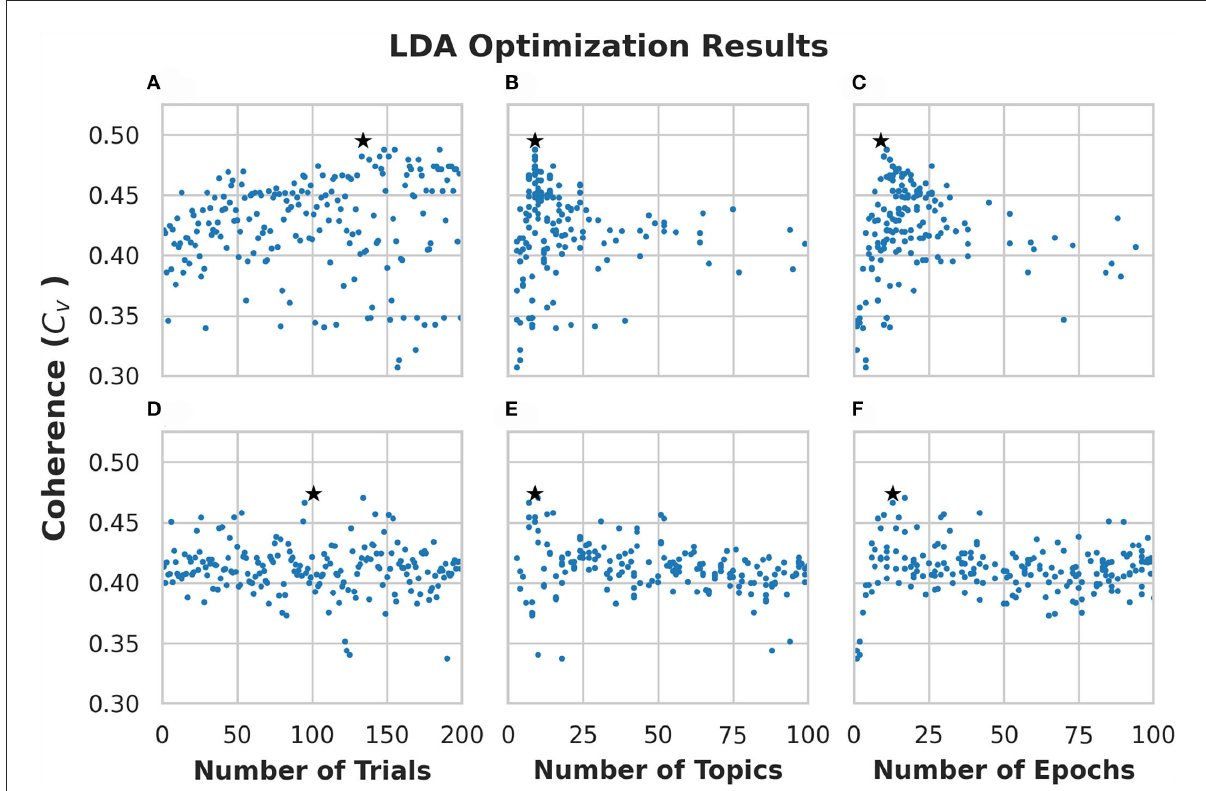
FIGURE2 Optimization results for Latent Dirichlet Allocation (LDA) topic modeling of subreddit “r/CysticFibrosis.” (A–C) Show results from the 200 trials using adaptive Tree-Based Parzen Estimator (ATPE). (D–F) Show results from the 200 trials using a random search. Each dot represents a single model that was created for each trial. The stars denote the highest coherence model for the respective optimization